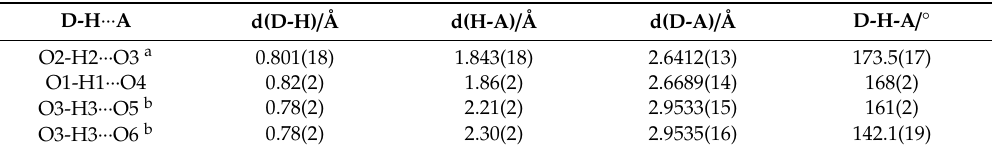
Table 2. Hydrogen bonds in the crystal structure of the bis(triethanolamine)nickel(II) dinitrate (Ni-TEA) complex.